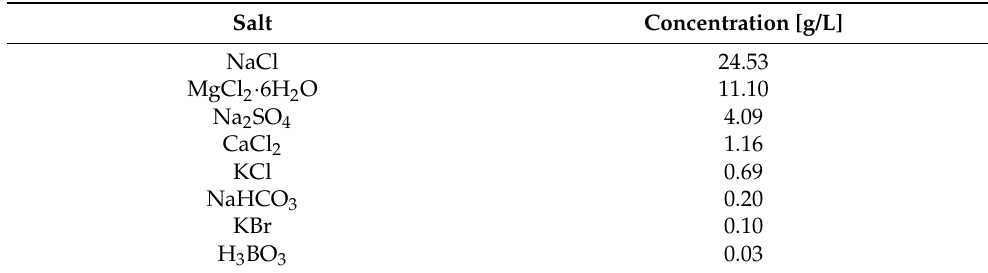
Table 1. Chemical composition of seawater (SW)